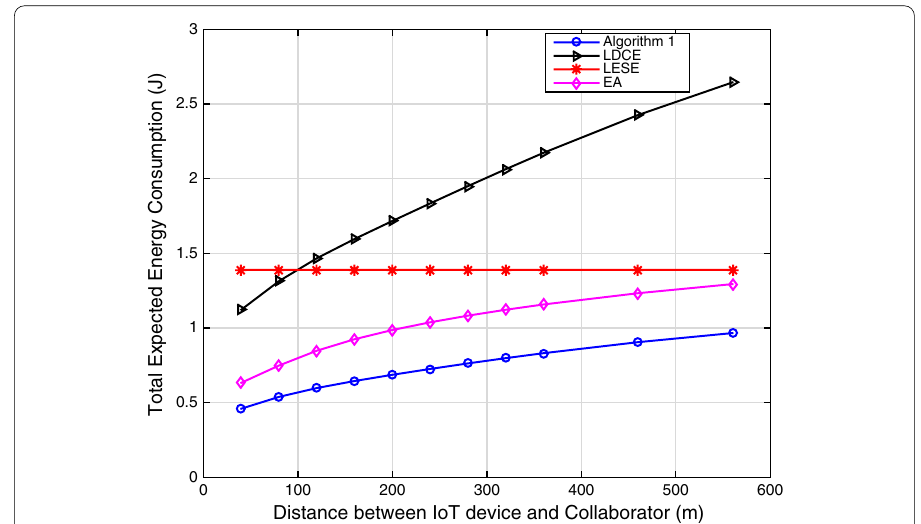
Fig. 7 Total expected energy consumption versus distance between IoT device and collaborator